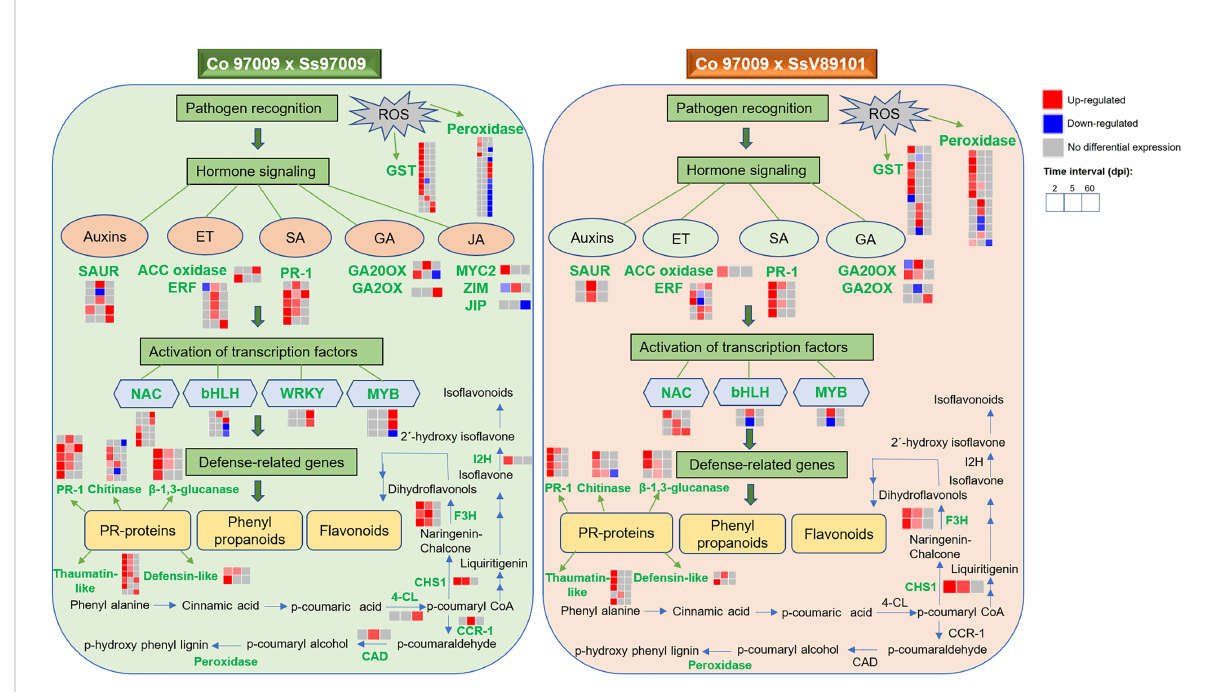
FIGURE 8 Overview of comparative gene expression pro fi le in sugarcane cultivar Co 97009 in response to S. scitamineum isolates, Ss97009 (high-virulent) and SsV89101 (low-virulent). Genes shown in green are differentially expressed with the respective isolates. ET, ethylene; SA, salicylic acid; GA, gibberellic acid; JA, jasmonic acid; ACC oxidase, 1-aminocyclopropane-1-carboxylate (ACC) oxidase; ERF, ethylene-responsive transcription factor; PR-1, pathogenesis-related protein 1; GA20OX, gibberellin 20 oxidase; GA2OX, gibberellin 2-beta-dioxygenase; JIP, jasmonate-induced protein; 4-CL, 4-coumarate-CoA ligase 3; CHS1, chalcone synthase 1; F3H, fl avonoid 3 ’ -hydroxylase; I2H, iso fl avone 2 ’ -hydroxylase; CCR-1, cinnamoyl-CoA reductase 1; CAD, cinnamyl alcohol dehydrogenase; and GST, glutathione